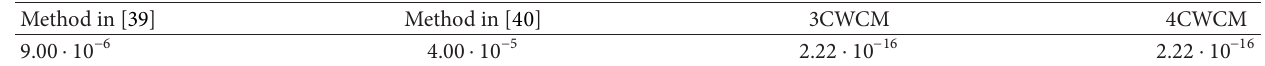
Table 3: The best errors for Example 2.